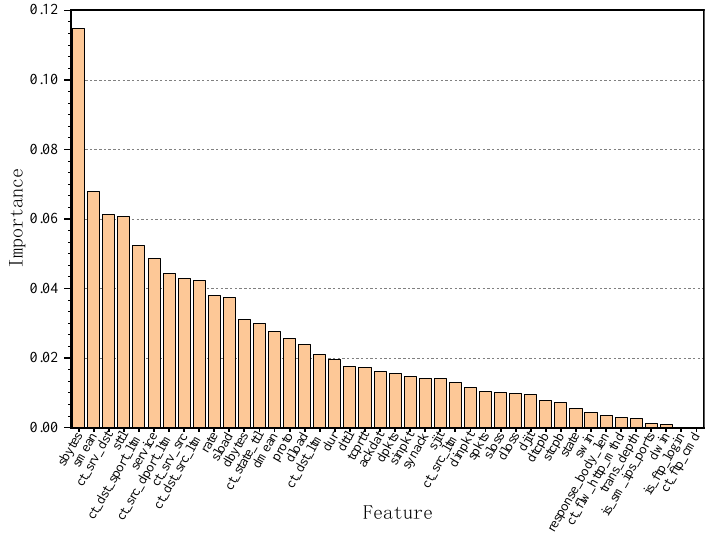
Figure 8. Feature importance map for the UNSW_NB15 dataset.